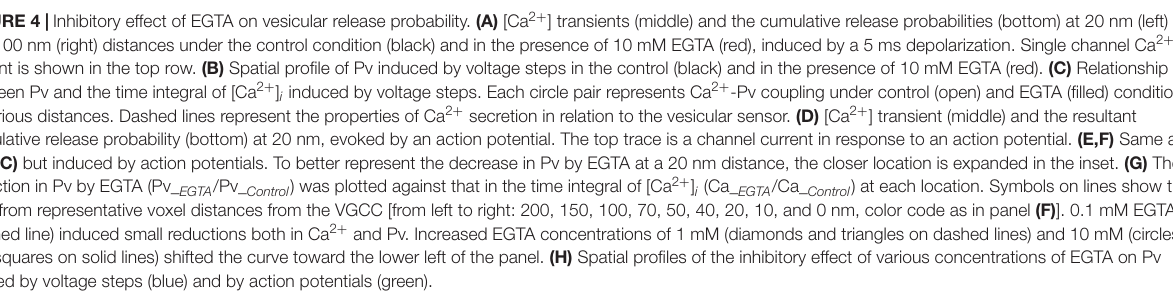
FIGURE 4 | Inhibitory effect of EGTA on vesicular release probability. (A) [Ca 2 + ] transients (middle) and the cumulative release probabilities (bottom) at 20 nm (left) and 100 nm (right) distances under the control condition (black) and in the presence of 10 mM EGTA (red), induced by a 5 ms depolarization. Single channel Ca 2 + current is shown in the top row. (B) Spatial profile of Pv induced by voltage steps in the control (black) and in the presence of 10 mM EGTA (red). (C) Relationship between Pv and the time integral of [Ca 2 + ] i induced by voltage steps. Each circle pair represents Ca 2 + -Pv coupling under control (open) and EGTA (filled) conditions at various distances. Dashed lines represent the properties of Ca 2 + secretion in relation to the vesicular sensor. (D) [Ca 2 + ] transient (middle) and the resultant cumulative release probability (bottom) at 20 nm, evoked by an action potential. The top trace is a channel current in response to an action potential. (E,F) Same as in (B,C) but induced by action potentials. To better represent the decrease in Pv by EGTA at a 20 nm distance, the closer location is expanded in the inset. (G) The reduction in Pv by EGTA (Pv_ EGTA /Pv_ Control ) was plotted against that in the time integral of [Ca 2 + ] i (Ca_ EGTA /Ca_ Control ) at each location. Symbols on lines show the data from representative voxel distances from the VGCC [from left to right: 200, 150, 100, 70, 50, 40, 20, 10, and 0 nm, color code as in panel (F) ]. 0.1 mM EGTA (dashed line) induced small reductions both in Ca 2 + and Pv. Increased EGTA concentrations of 1 mM (diamonds and triangles on dashed lines) and 10 mM (circles and squares on solid lines) shifted the curve toward the lower left of the panel. (H) Spatial profiles of the inhibitory effect of various concentrations of EGTA on Pv evoked by voltage steps (blue) and by action potentials